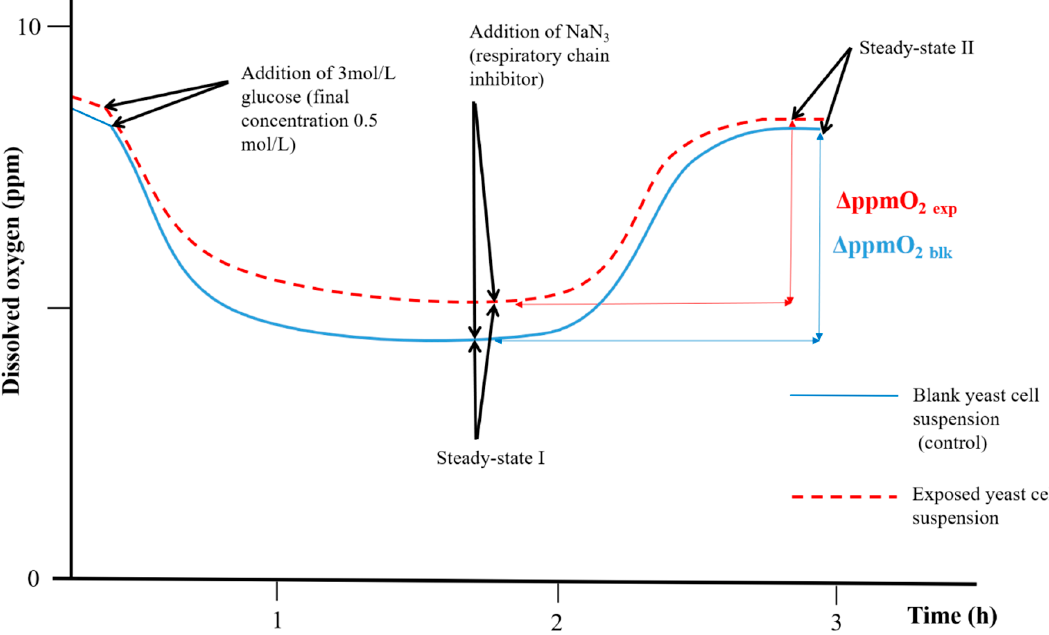
Figure 3. The experimental respirometric curve shows the dissolved oxygen (ppm O 2 ) vs time (adapted from Dragone et al.